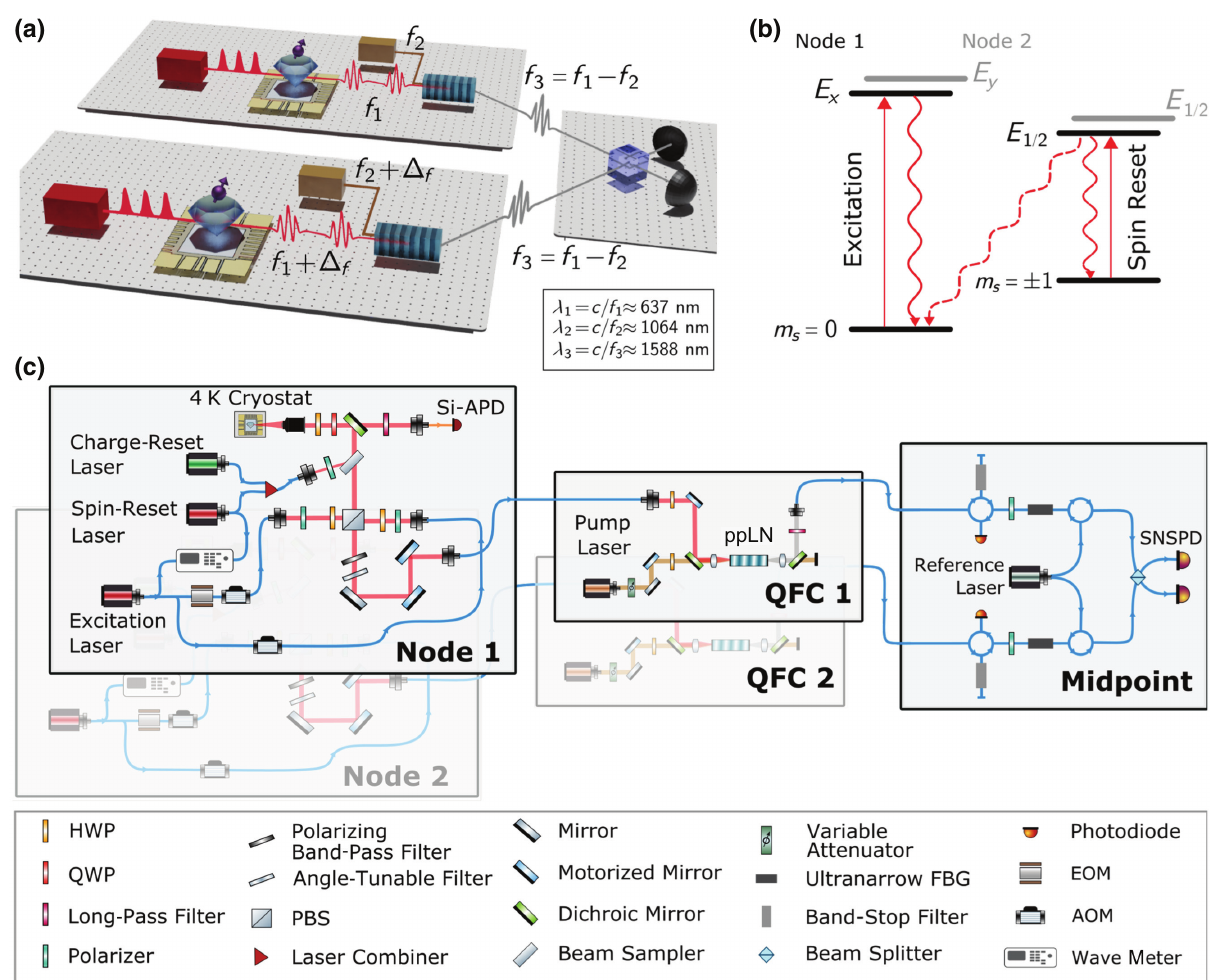
FIG. 1. The layout of the two independent network nodes and the midpoint. (a) A schematic of the main components of the setup. Pulses excite the NV center, which emits single photons through spontaneous decay. The photons are converted to telecom wavelength and guided toward a midpoint placed in the neighboring laboratory, where they interfere on a beam splitter (for more details on optics, see the Supplemental Material [25]). (b) The NV-center level structure, showing the spin levels in the ground state and the relevant optical transitions. The optical transitions of the two nodes have different energies due to local variations in strain (see text). (c) A detailed schematic showing the optics used for full operation of the system. The nodes are identical and no hardware is shared between the systems. Each node has a set of charge reset, spin reset, and excitation lasers, which are modulated, combined, and focused via a high-NA objective onto the NV center. The phonon-side-band (PSB) [zero-phonon-line (ZPL)] emission from the NV center is filtered using frequency (polarization) filtering and coupled into a multi- (single-) mode fiber. The PSB emission is measured locally on an Avalanche Photodiode, while the ZPL emission is sent to the quantum-frequency-conversion (QFC) module. Stabilization light is split off from the excitation path and brought into the single-photon path via a polarizing beam splitter. The QFC module contains remotely controllable optics to align the input, pump, and converted fields to the waveguide on the periodically poled lithium niobate (ppLN) crystal that converts both the single photons and stabilization light. Polarization-maintaining (PM) fibers transport the photons to a midpoint where the single photons are filtered and separated from the stabilization light using a combination of in-fiber filters. The single photons interfere on a beam splitter and are measured by single-photon superconducting nanowire detectors (SNSPDs), while the stabilization light interferes with the reference laser and is measured on a